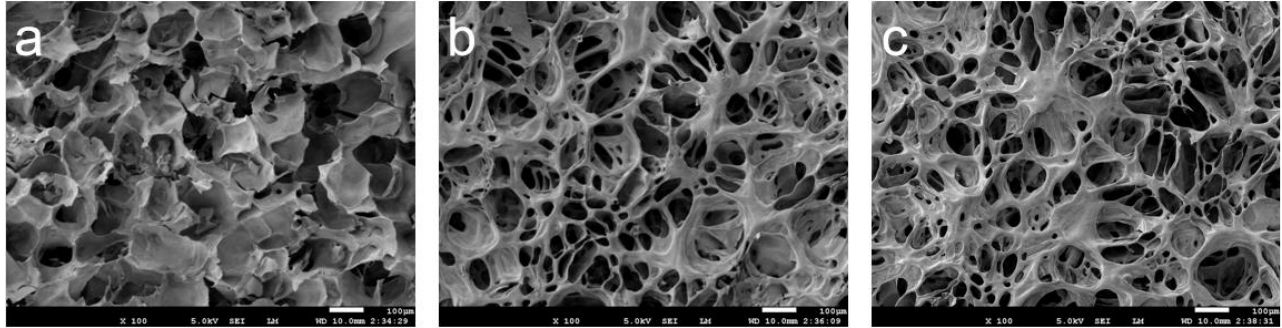
Figure 5. SEM images of ( a ) H1 (7% terpyridine content), ( b ) H2 (10% terpyridine content), ( c ) H3 (13% terpyridine content).